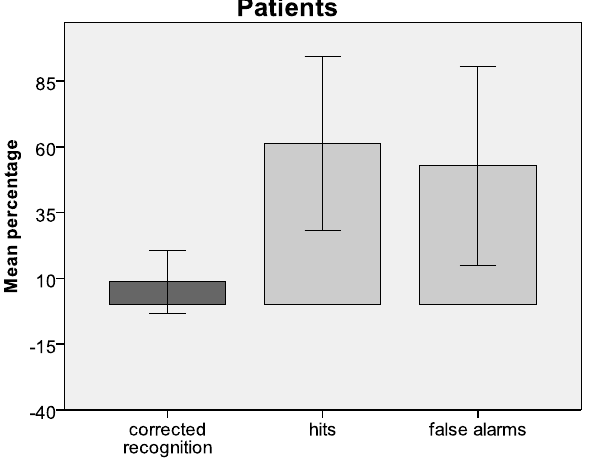
Figure 1. Relative overall face recognition performances for Mild Cognitive Impairment (MCI) patients and age-matched controls (corrected for guessing) (bars in dark grey). Only the number of false alarms shows a trend towards significant difference between MCI patients and controls. This might reflect a difference in response criterion. Patients are more liberal than controls in their